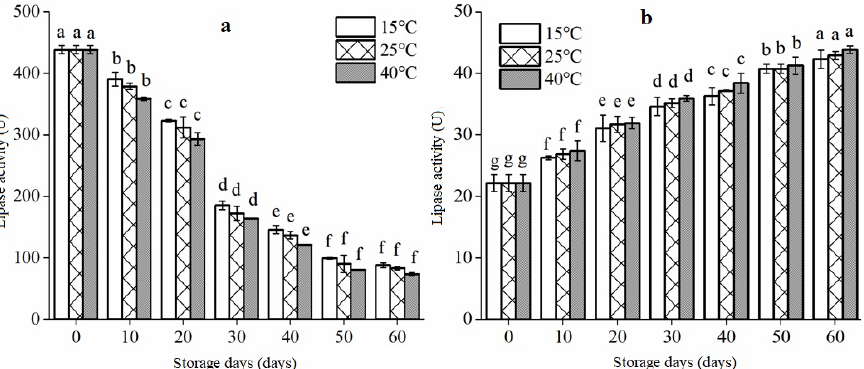
Figure 3. Changes in lipase activity of rice bran treated by extrusion. Note: ( a ) untreated rice bran; ( b ) extruded rice bran. The letters in the figure indicate significant differences between different treatment times and storage conditions, with a significance level of p < 0.05.